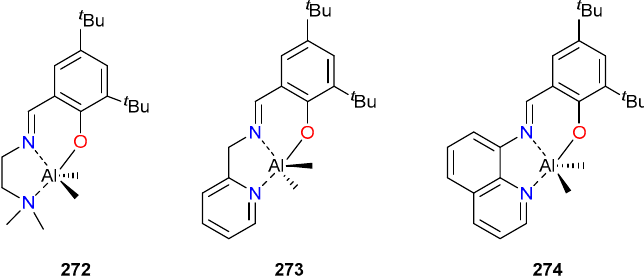
Figure 41. Tridentate Al-based catalysts 272–274 active in the homo- and co-polymerization of ε -CL and δ -VL [122].